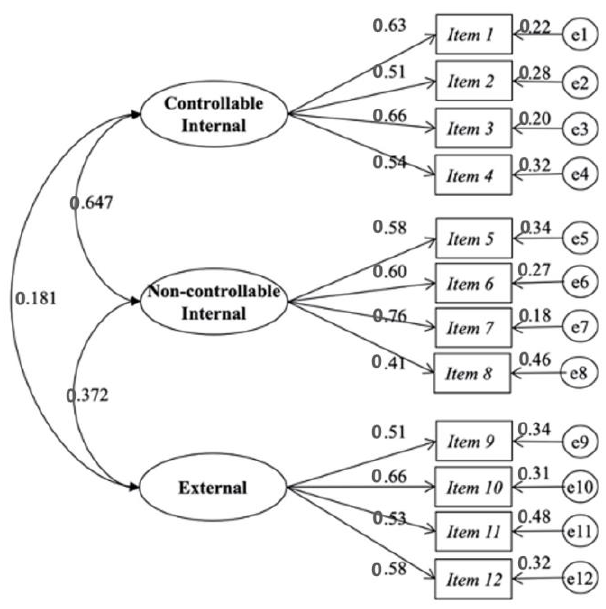
Figure 1. Model of three related factors of the Scale of Attributions of the Academic Success. Similarly, the t-values (range 7.14–19.90) of the unstandardized regression coefficients of the failure attributions model were statistically significant. The range of standardized coefficients for factor one (0.742–0.865), two (0.706–0.759) and three (0.451–0.791) were statistically significantly related, demonstrating the consistency of the indicators for the measurement of the constructs (Figure 2).